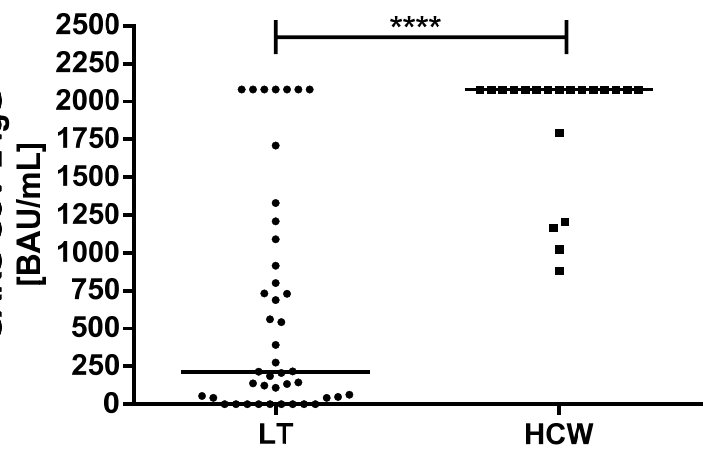
Figure 1. Comparison of the binding antibody units per milliliter (BAU/mL) ratio of SARS-CoV-2 IgG antibodies of the LT recipients and HCWs after the second vaccination. HCW: healthcare worker; BAU: binding antibody units; ml: milliliter; SARS-CoV-2: severe acute respiratory syn- drome coronavirus type 2. **** p < 0.0001.